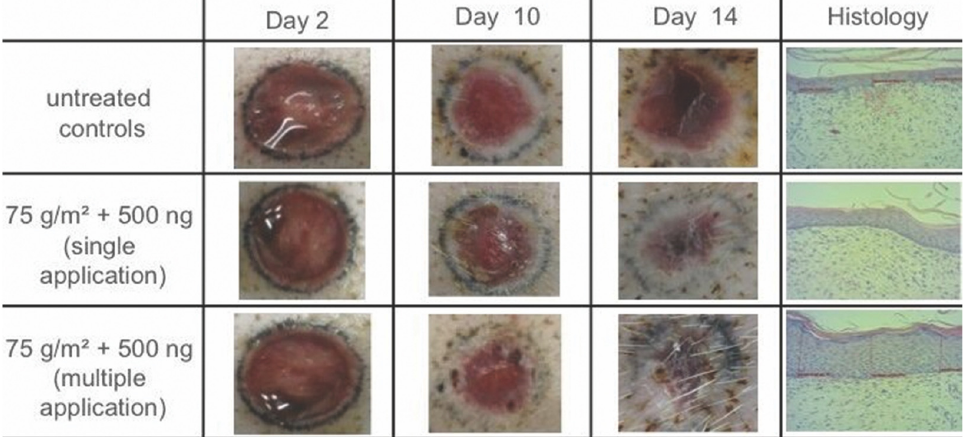
Figure 2. Photographic and histological documentation. A macroscopic overview of epithelialization during wound healing in a representative untreated control, a wound treated once with the 75 g/m 2 collagen–gelatin scaffold and 500 ng rhGDF-5, and wounds treated multiple times with the 75 g/m 2 collagen–gelatin scaffold and 500 ng rhGDF-5 on days 2, 10, and 14. On day 21, microscopic images were taken from tissue stained with